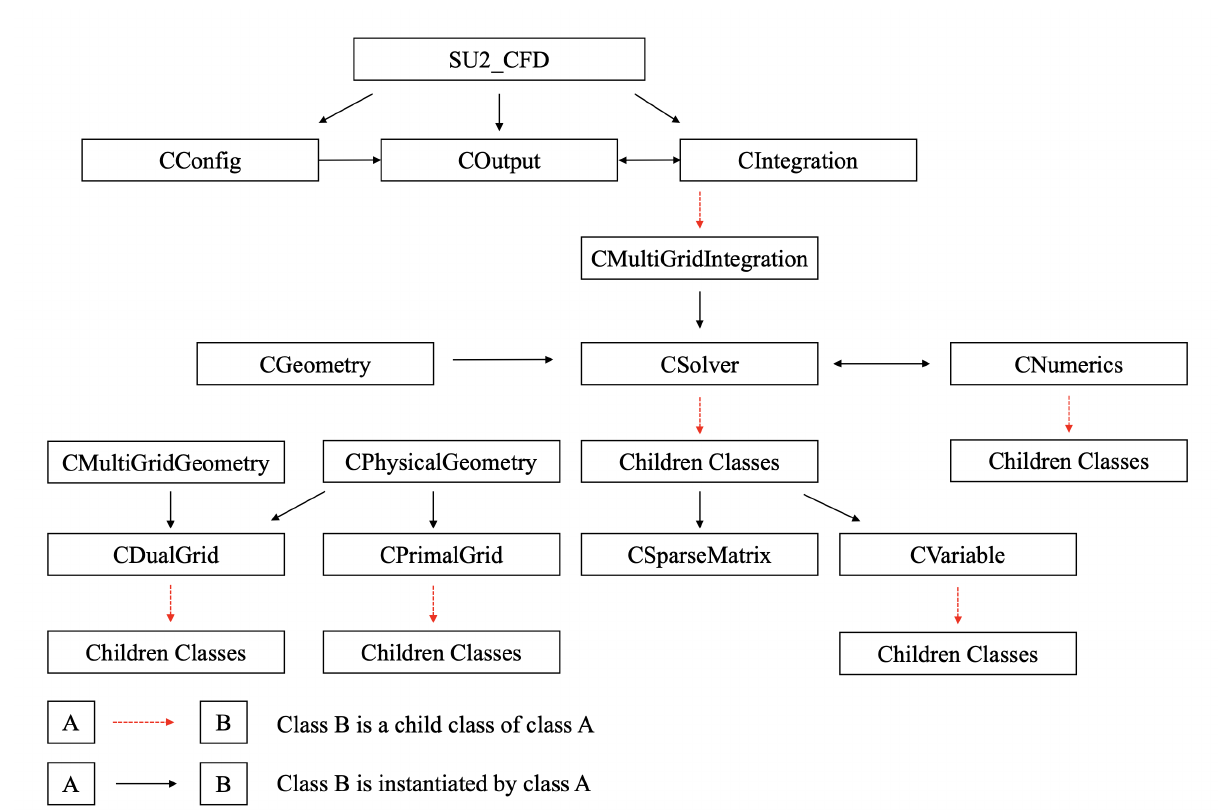
Figure 1. SU2 class architecture with parent–child and class instantiation relationships.